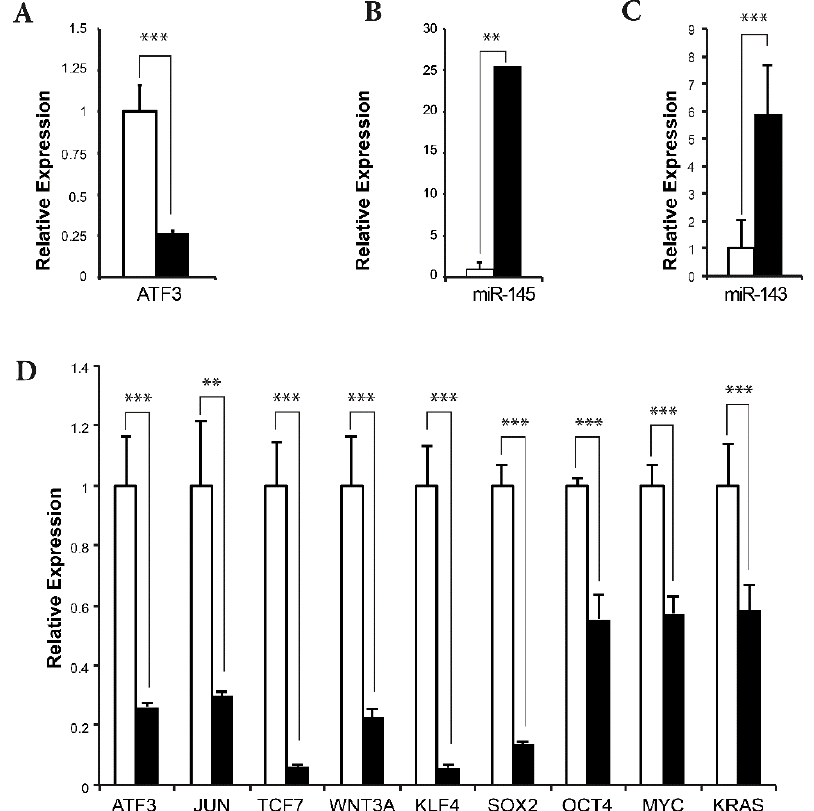
Figure 6. Effects of ATF3 knockdown on the expression of selected genes in the TNBC cell line MDA-MB-157 determined by RT-qPCR. ( A ) Plot showing the relative expression of ATF3 in the presence of either a scrambled shRNA (white), or an ATF3 shRNA (black). ( B ) As in A, but for miR-145. ( C ) As in A, but for miR-143. ( D ) As in A but for ATF3 , JUN , TCF7 , WNT3A , KLF4 , SOX2 , OCT4 , MYC , and KRAS . ** p < 0.05, *** p < 0.005.